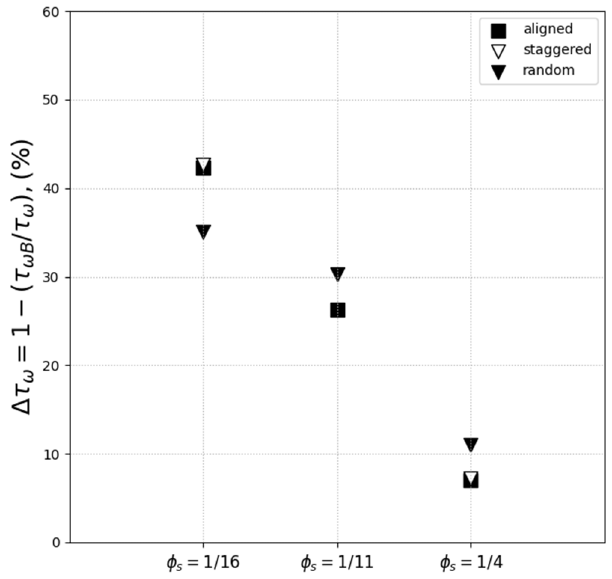
Figure 13. Superhydrophobic surface shear stress reductions as a function of the friction Reynolds number for three different distributions of post types: ( ■ ) aligned, ( ▽ ) staggered, and ( ▼ ) random distributions.